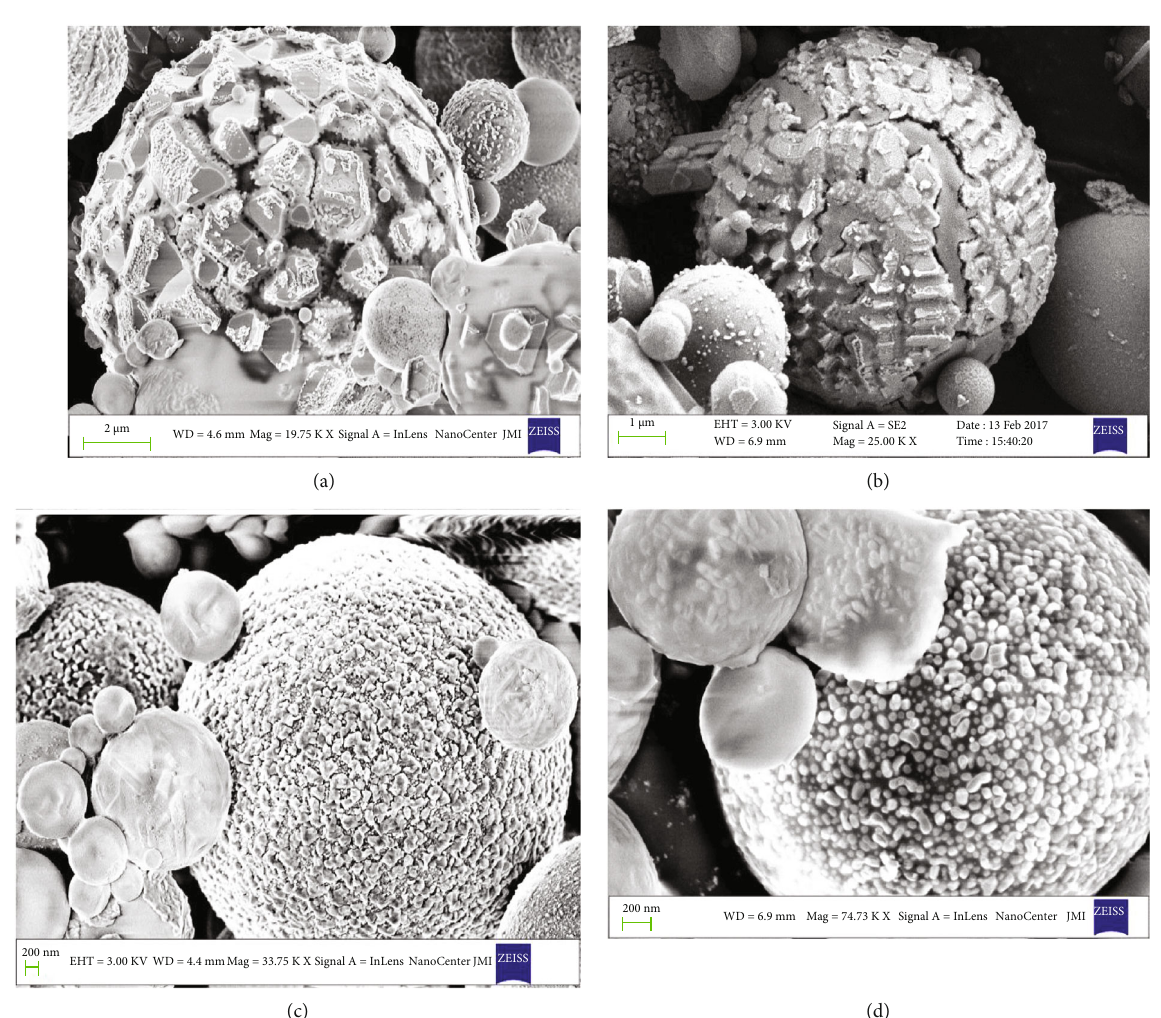
Figure 3: FESEM micrographs of FS: (a) angular deposits, (b) crystalline pattern, (c) spherules deposits, and (d) minute spherule deposits.